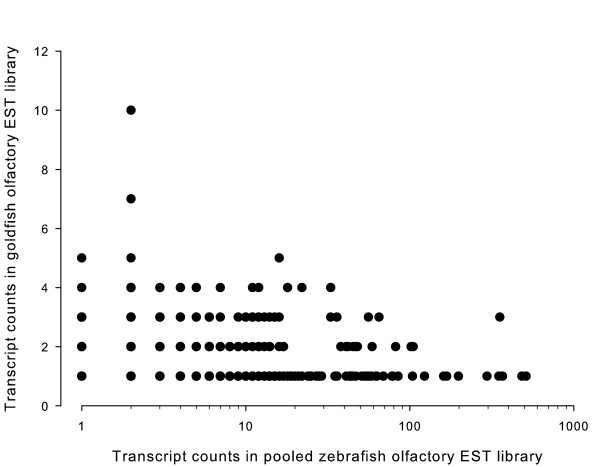
Frequency of common transcripts between goldfish and zebrafish olfactory EST libraries. Semi-logarithmic plot of counts of each transcript present in both the goldfish normalized and zebrafish non-normalized EST library. The almost uniform relationship (R = 0.009) is a strong indication of absence of amplification bias during normalization.